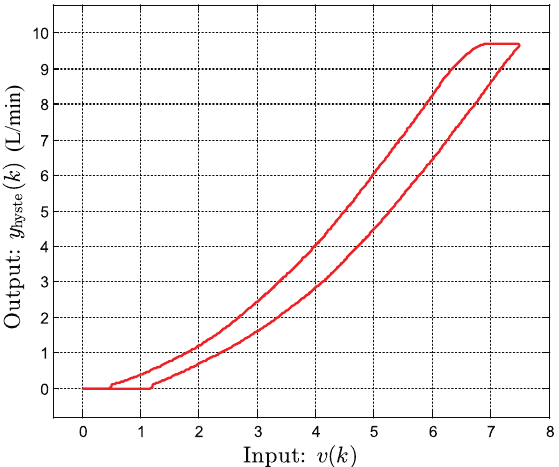
Figure 3. Input-output relationship between the input v ( k ) and the measured output y hyste ( k )